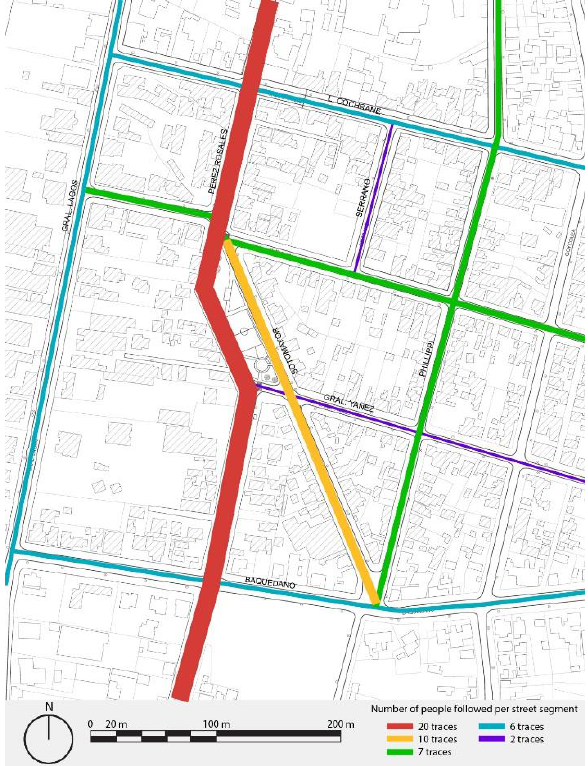
Figure 4. Pedestrian movement pattern map of Barrios Bajos, Valdivia. Source: Authors.